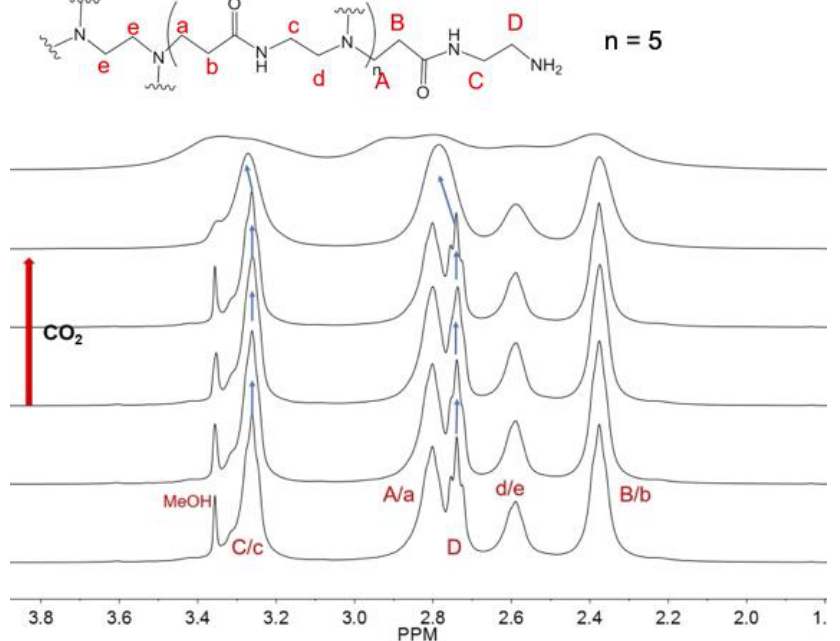
Figure 5. 1 H NMR spectra (400 MHz, CD 3 OD) of G5 dendrimer (0.02 M) upon addition of CO 2 (g) to the solution. Blue arrows are intended to guide the eye.